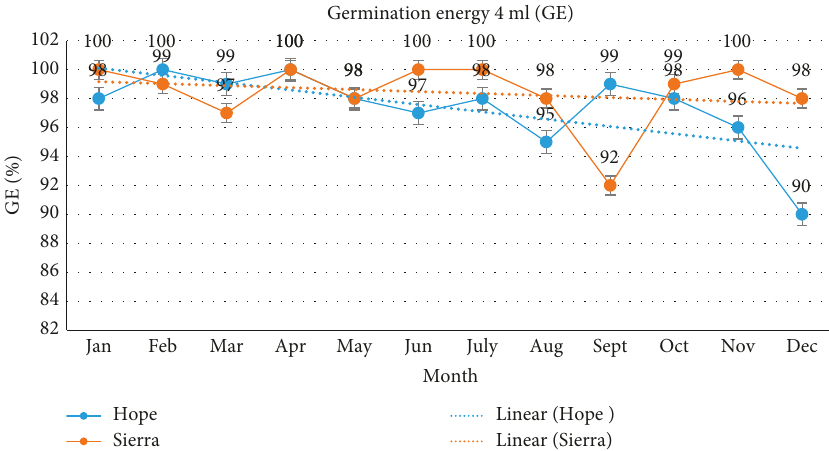
Figure 2: Comparison of germination energy (4ml) trends for Hope and Sierra malting barley varieties over the 12-month storage period.